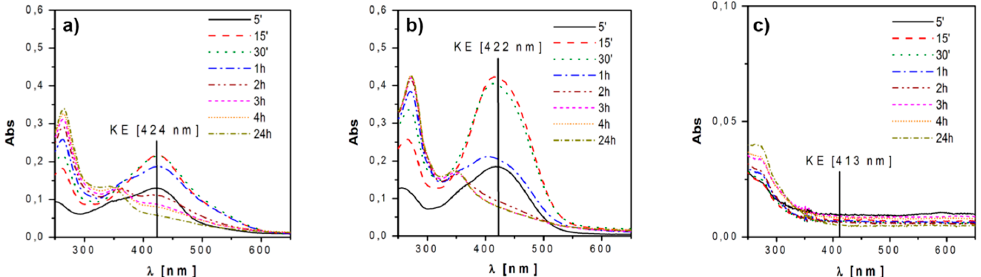
Figure 3. Static release tests performed in pure water at different times: ( a ) curcumin; ( b ) K2T21; and ( c ) K2T23.